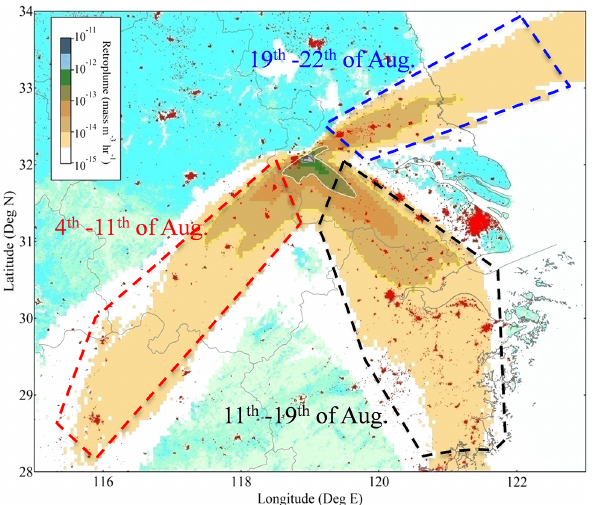
Figure 14. Retroplumes from 4 to 22 August 2013 identified with three main periods. Note: red points denote the urban area.